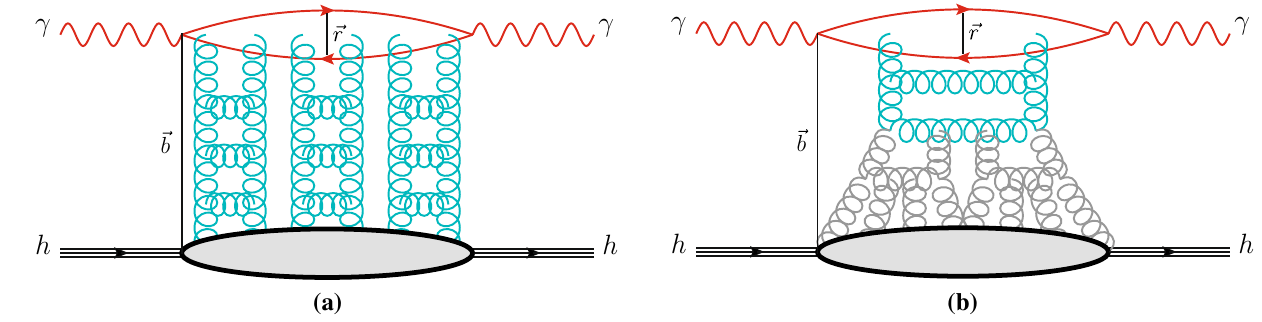
Fig. 2 Diagramatic representation of the saturation effects included in the a IP-SAT and b bCGC models for the description of the dipole-hadron scattering amplitude at high energies